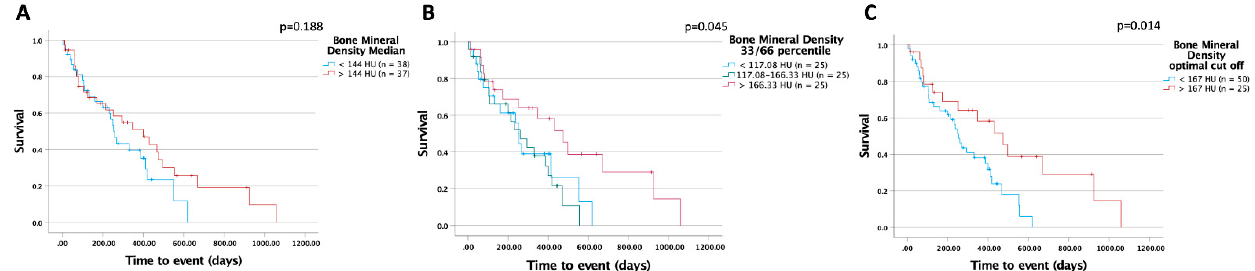
Figure 4. BMD is a predictor of survival in patients with advanced CCA. Patients with BMD above the median of 144 HU tend to have improved overall survival ( A ). Patients with a BMD above the 66th percentile ( B ) or above an optimal cut-off value of 167 HU ( C ) had a significantly longer overall survival.